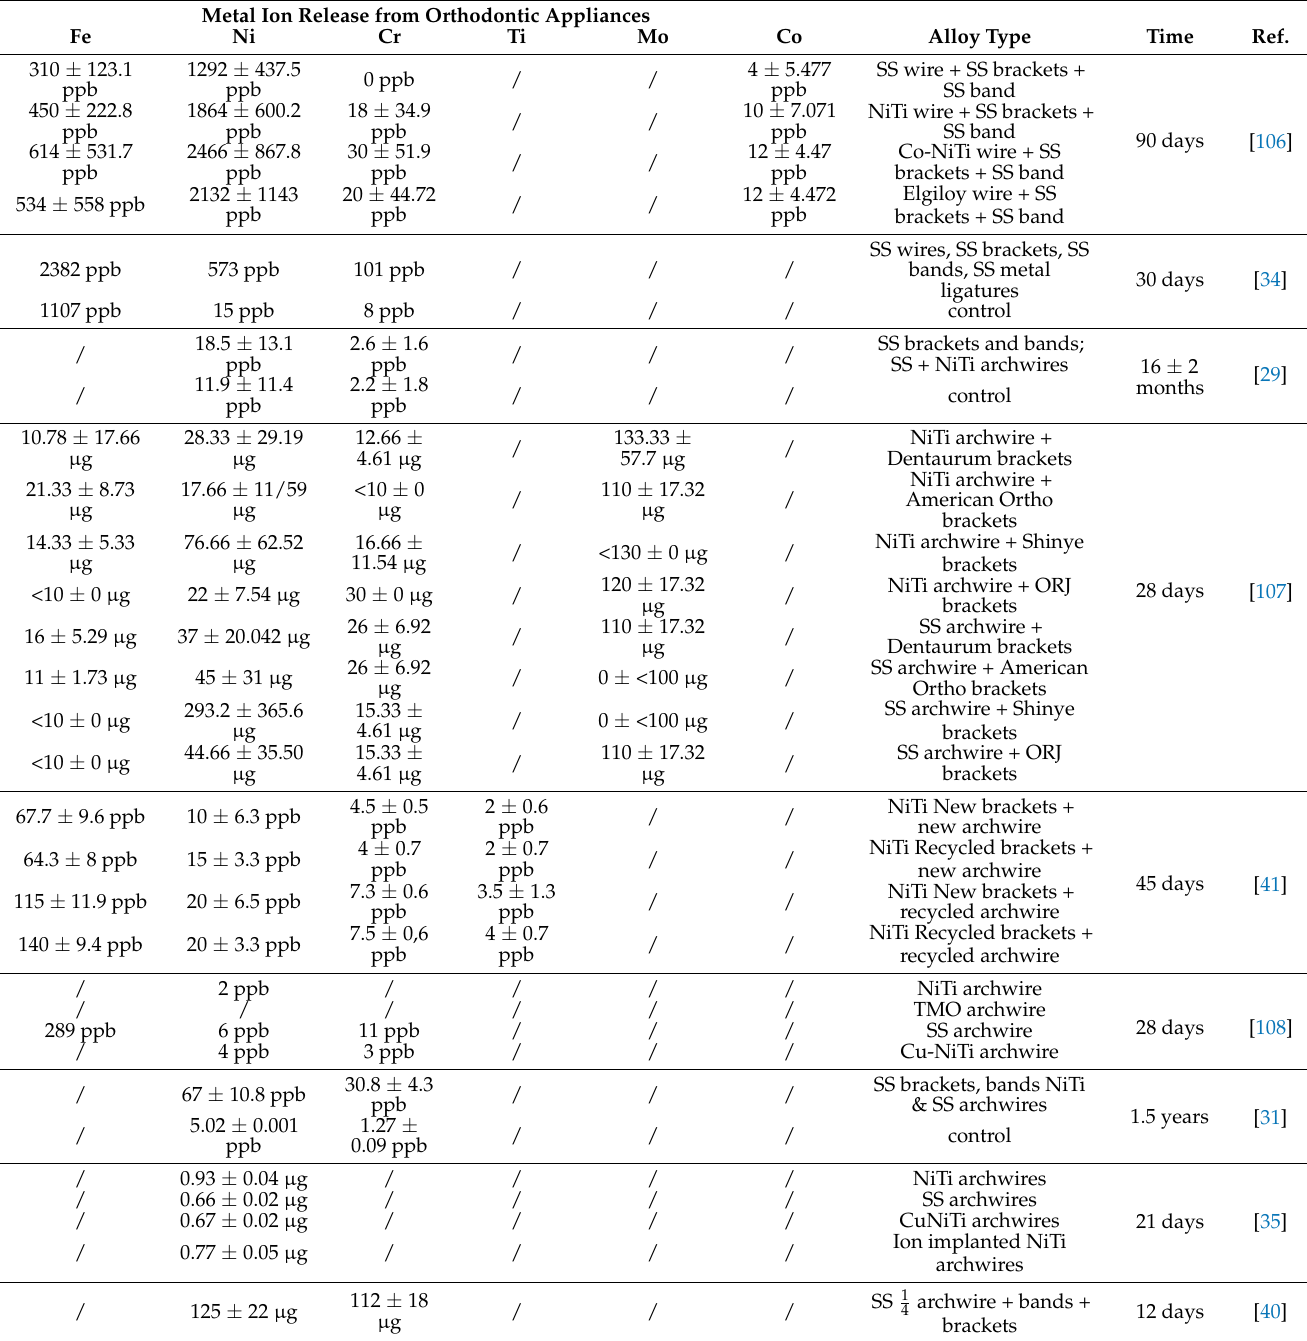
Table 3. Average concentrations of leached metal ions from orthodontic appliances. Metal Ion Release from Orthodontic Appliances Fe Alloy Type